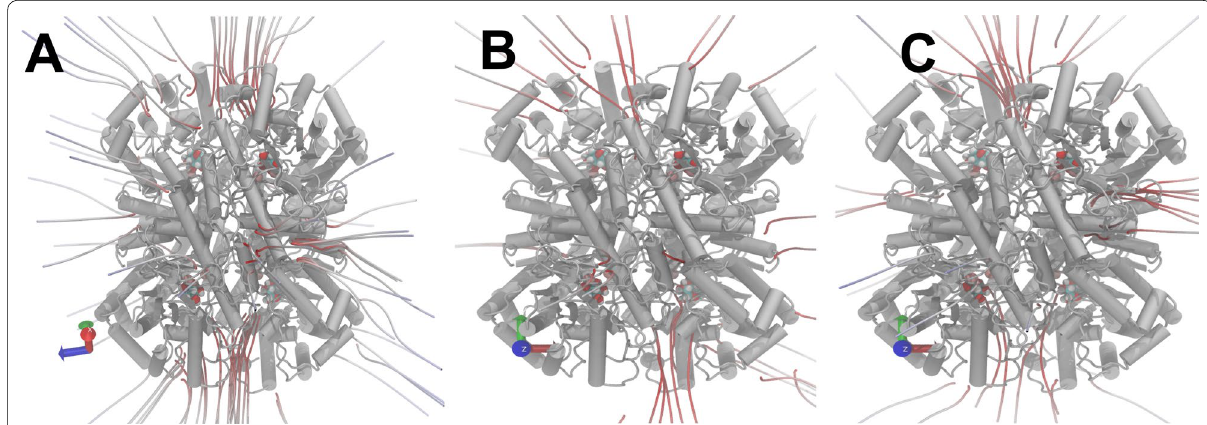
Fig. 4 Electric field representation. A B. cenocepacia . B C. phytofermentans . C Piromyces sp. Red lines represent a negative charges. Blue lines represent positive charges. Grey lines represent neutral charges. Black arrows show the active site